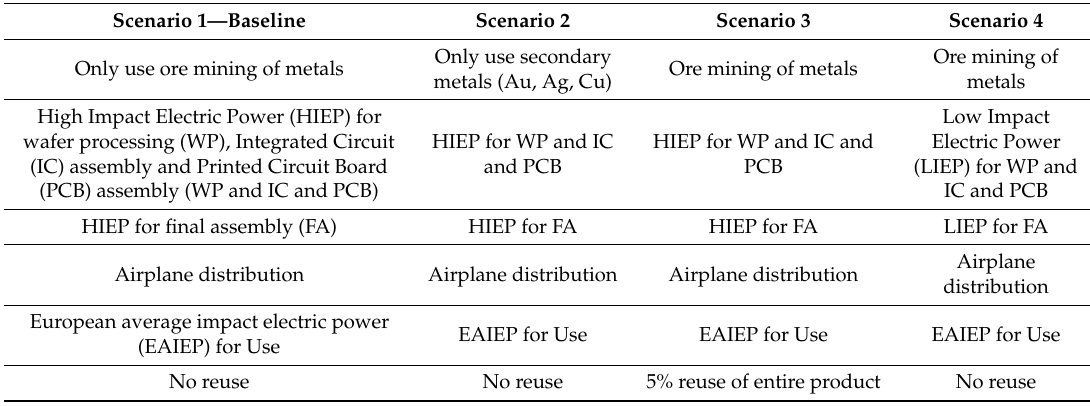
Table 1. Scenarios for the Virtual Reality (VR) headset